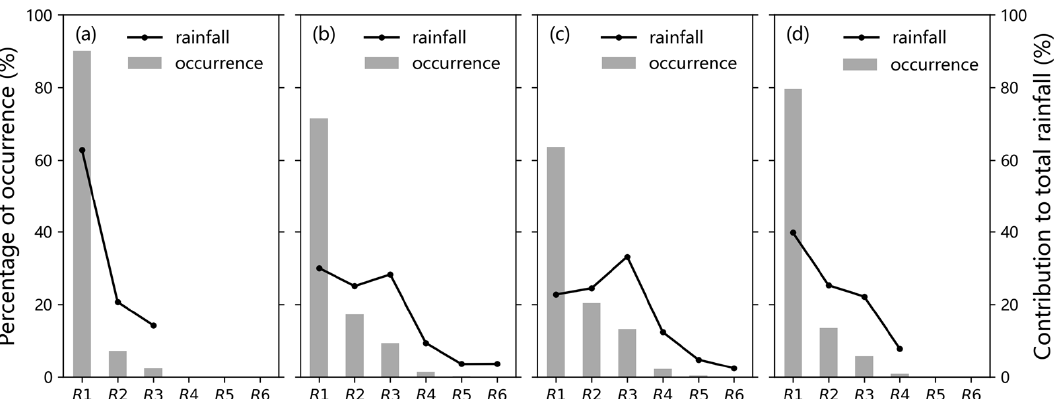
Figure 7. Percentages of occurrence (bar) and relative contributions to the total rainfall (line) from the different R bins in the four seasons: winter ( a ), premonsoon ( b ), monsoon ( c ) and postmonsoon ( d ).